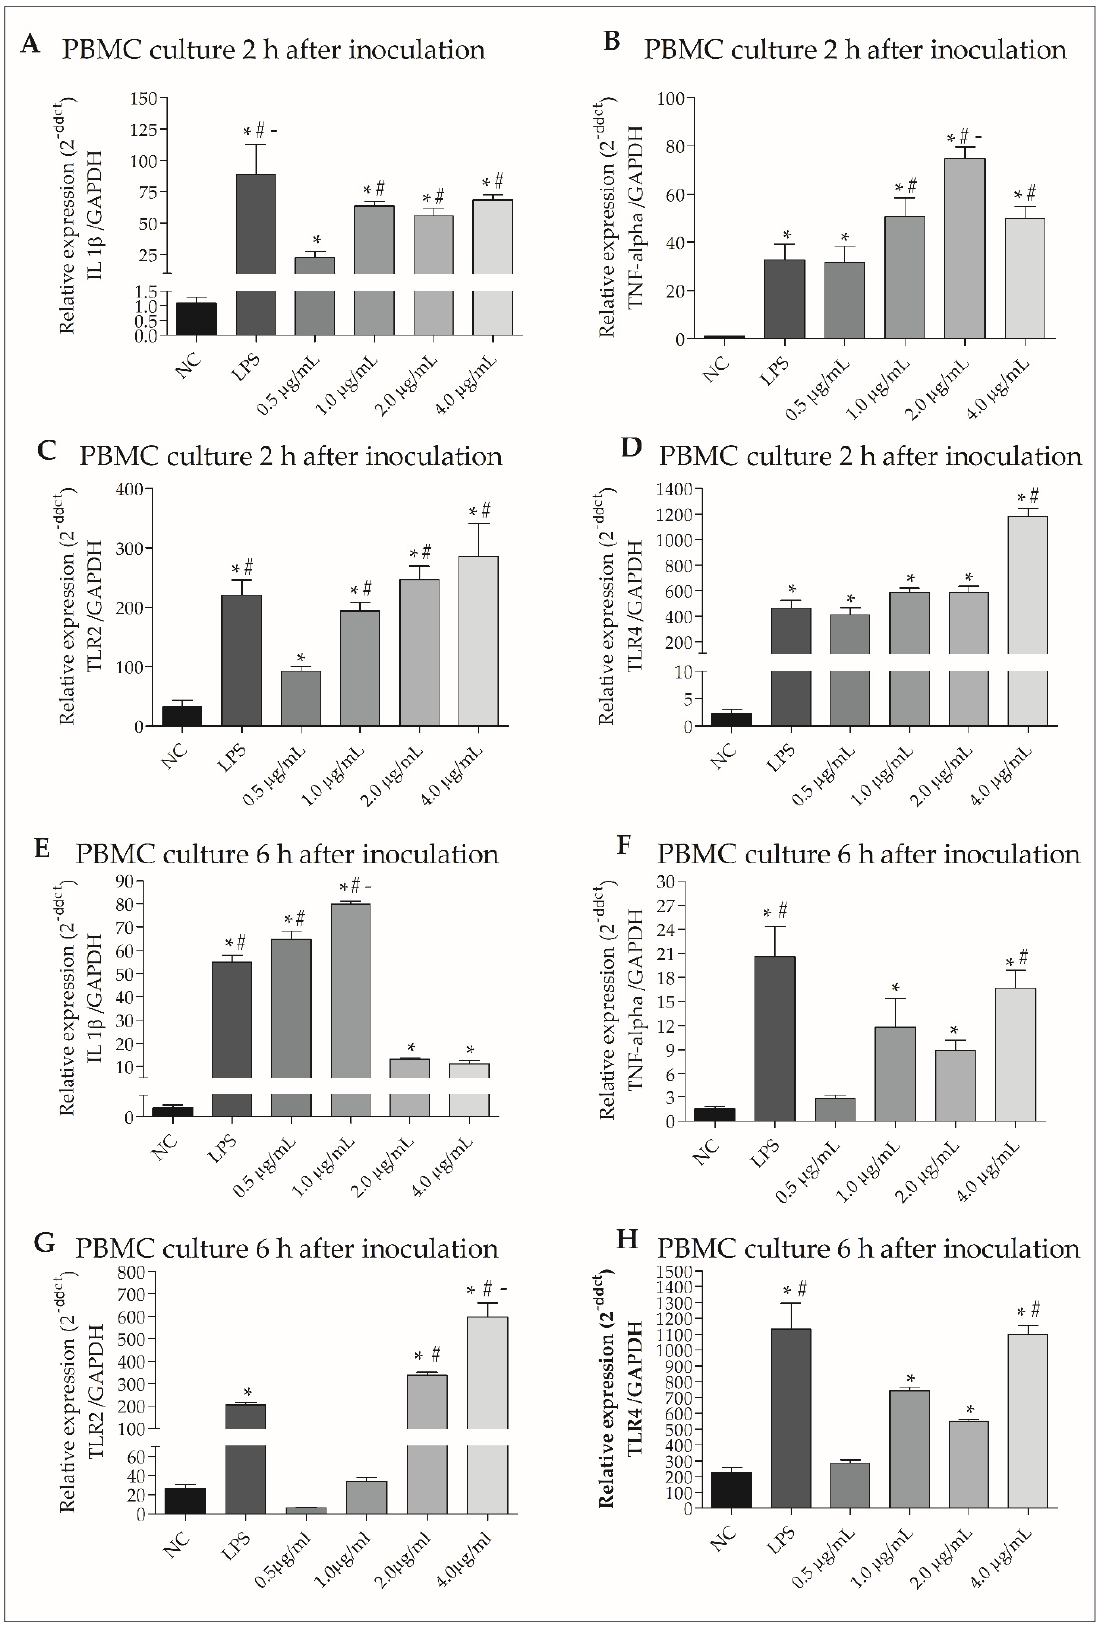
Figure 5. Gene expression of cytokines (interleukin 1 beta (IL-1 β ), tumour necrosis factor alpha (TNF- α ), and toll-like receptor (TLR)) in bovine peripheral blood mononuclear cells (PBMCs)